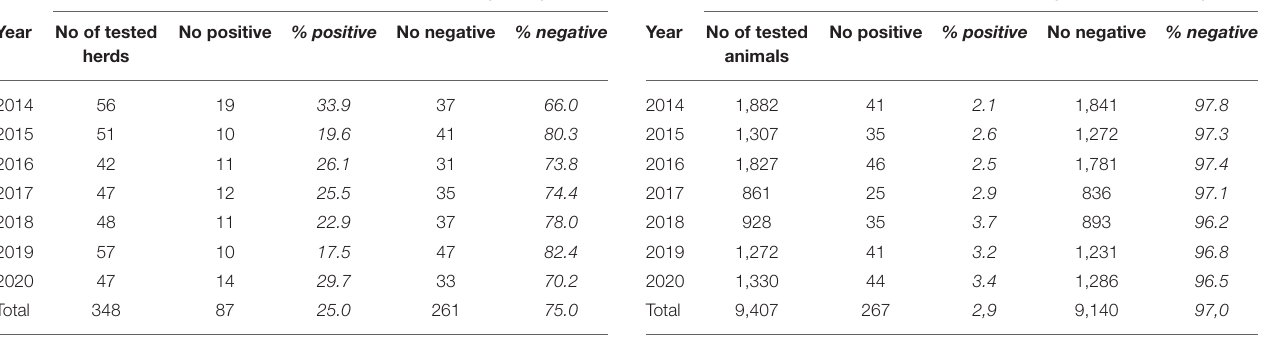
TABLE 3 | Results of tested animals by real-time RT-PCR for the detection of BVDV within voluntary BVDV control programme in Slovenia (2014–2020). Tested animals - detection of BVDV (real-time RT-PCR) Year No of tested